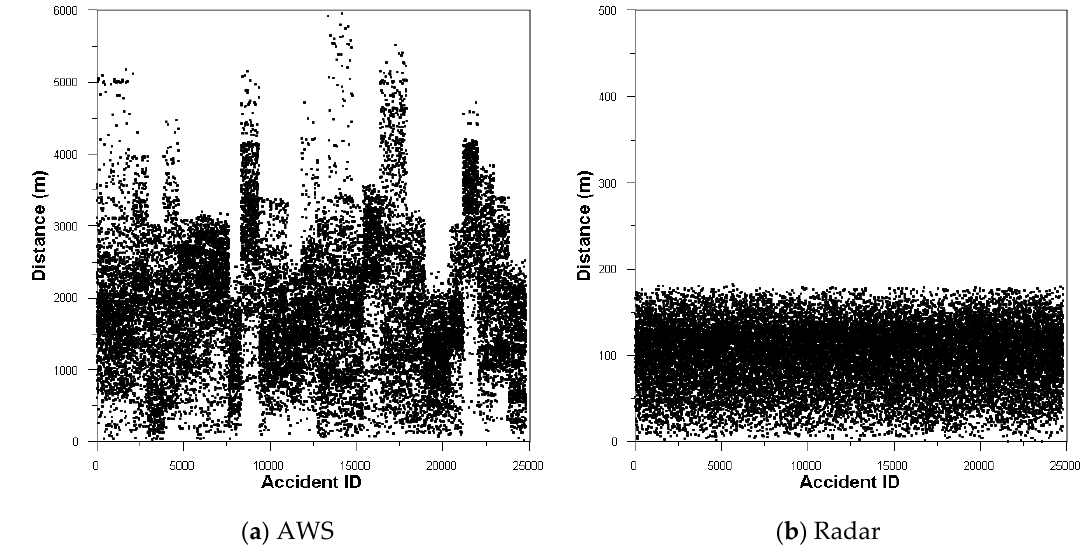
Figure 2. Distance between accident location and ( a ) nearest AWS location and ( b ) 250 m radar grid point.